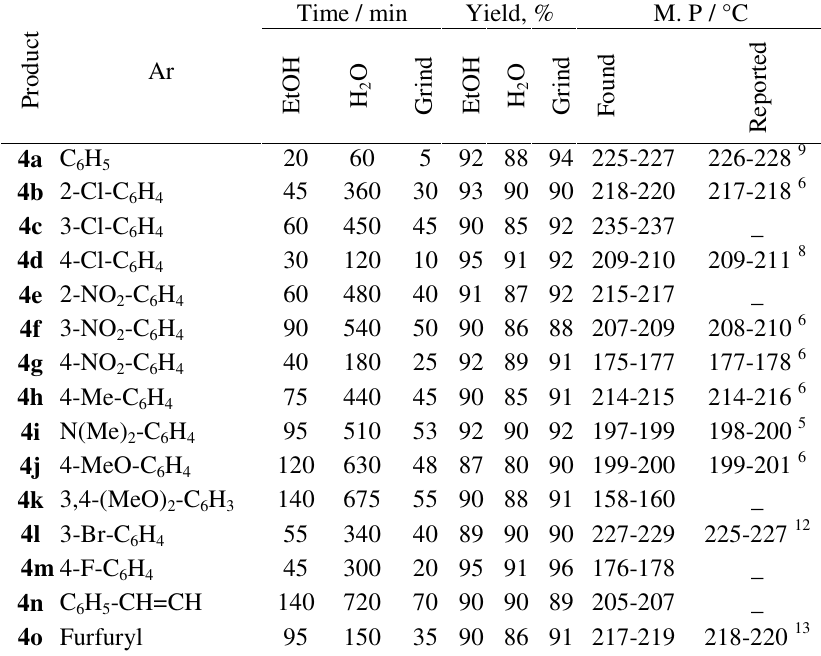
Table 1 . Synthesis of tetrahydrobenzo[ b ]pyrans catalyzed by TBABr. Time / min Yield, % M. P /